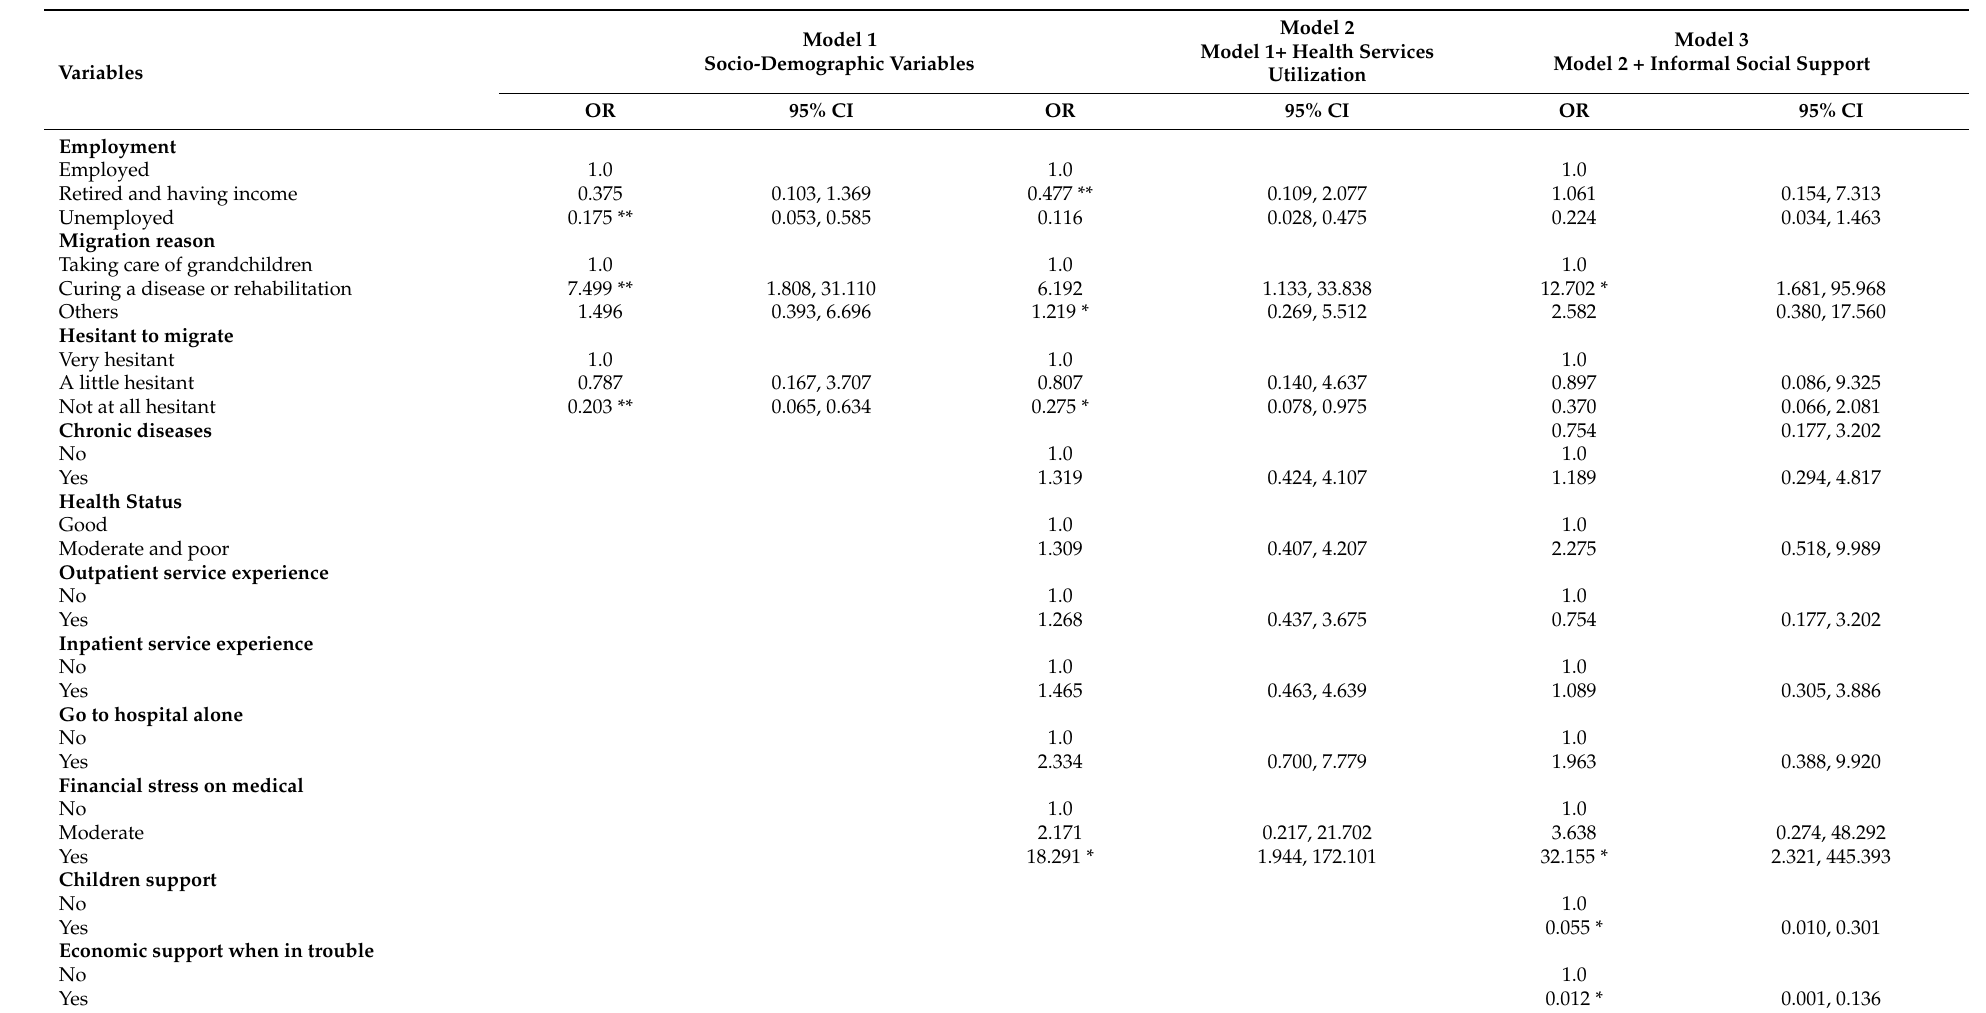
Table 4. Binary logistic regression for relationships between related variables and stress of